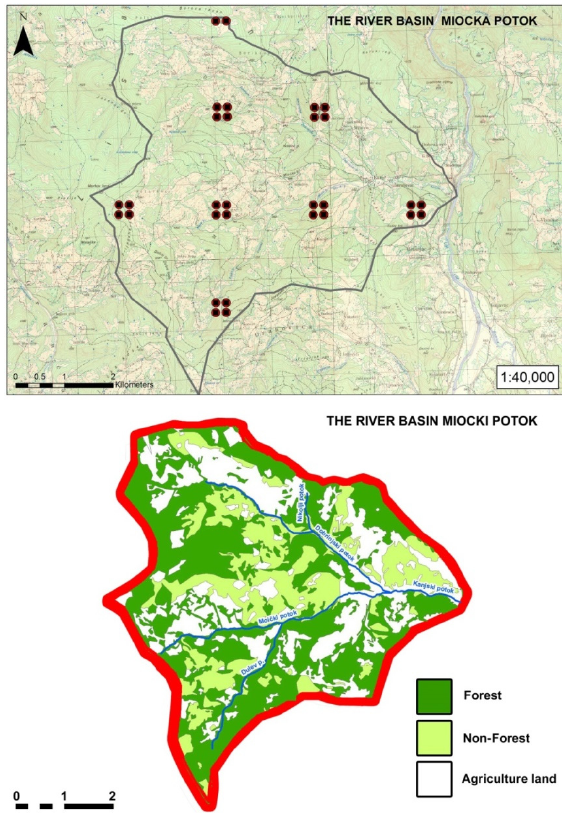
Figure 9. Position of clusters in the river basin study area ( left ) and forests within the basin ( right